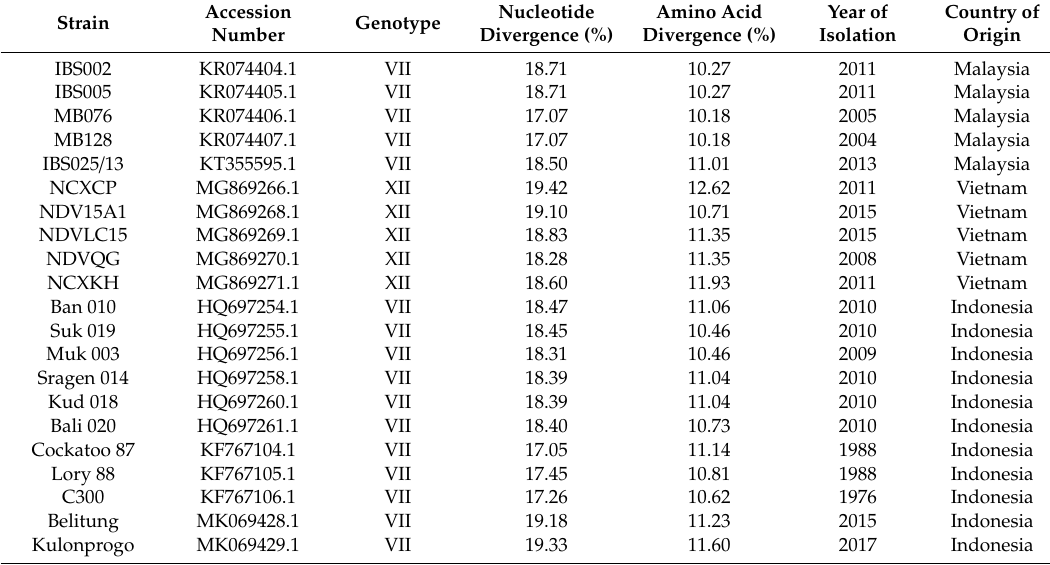
Table 1. Fusion protein nucleotide and amino acid distances between LaSota vaccine (JF950510.1) and other virulent NDV isolates in Southeast